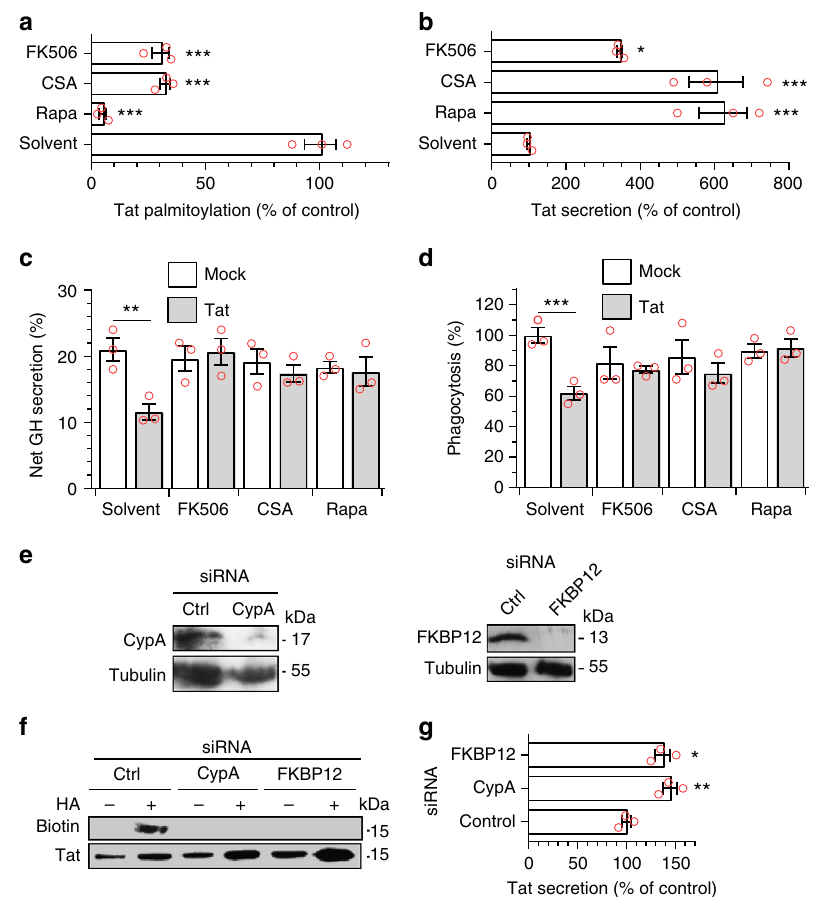
Fig. 6 Cyclophilin A and FKBP12 are required for Tat palmitoylation and Tat-mediated inhibition of PI(4,5)P 2 -dependent membrane traf fi c. a PC12 cells were transfected with Tat-FLAG before treatment for 6 h with 1 µ M FK506, 2 µ M CSA, 1 µ M rapamycin or solvent. Palmitoylation was then assayed using acyl-biotin exchange before band quanti fi cation. Results are expressed as biotin/Tat intensity ratio (% of control). b Jurkat T-cells were transfected with Tat before adding drugs for 6 h and assaying Tat secretion by ELISA. c PC12 cells were transfected with GH before drug treatment for 6 h and GH secretion assay. d Human MDMs were treated with the drug for 5 h before assaying phagocytosis of IgG-coated beads. e PC12 cells were transfected with the indicated siRNA before lysis then anti-CypA or anti-FKBP12 then anti- α tubulin western blot. f PC12 cells were cotransfected with the indicated siRNA and Tat-FLAG before detecting Tat palmitoylation using acyl-biotin exchange. (HA, hydroxylamine). g Jurkat cells were cotransfected with Tat and